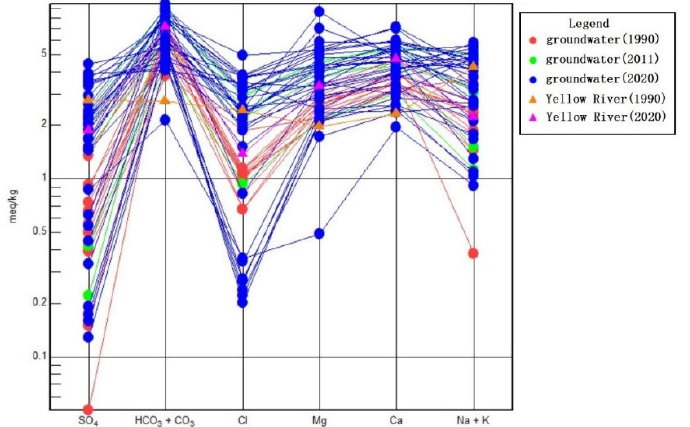
Figure 9. Chemical components of groundwater and Yellow River water in different periods in the study area.